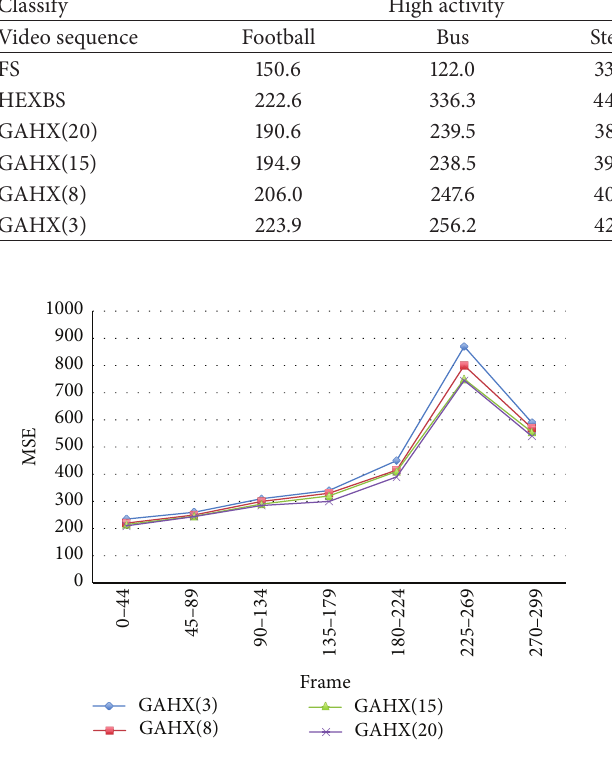
Figure 20: Average MSE per block for Stefan video sequence using various generation with the proposed technique.